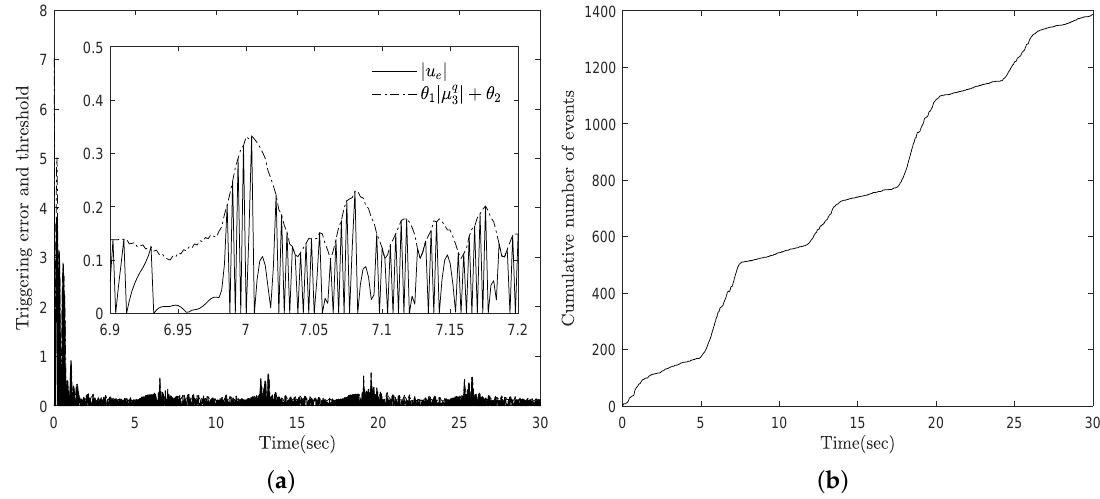
Figure 9. Triggering threshold and the comparison of the cumulative number of events of the proposed approach for Example 2 ( a ) | u e | and θ 1 | µ q